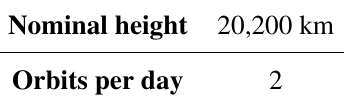
Table 6. GPS orbit parameters.